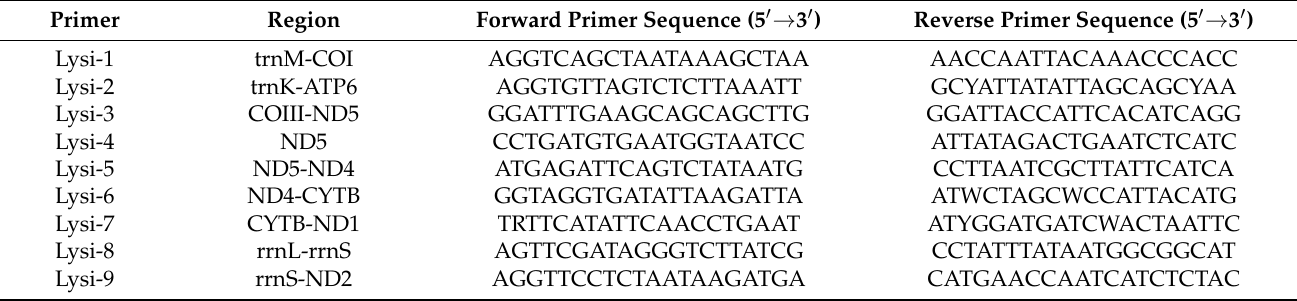
Table 1. Primers used for completing the mitogenome of L. singoriensis .